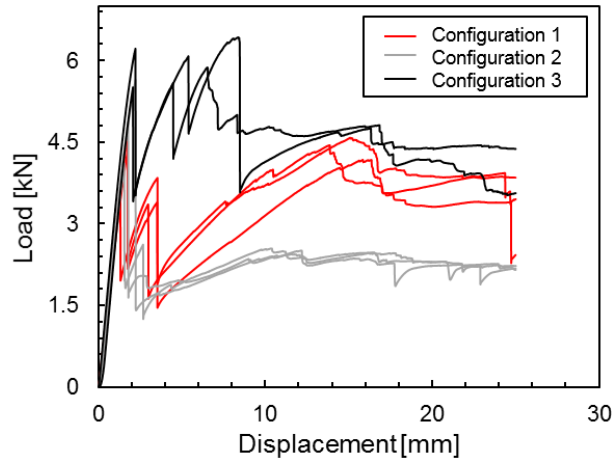
Figure 8. Comparison between the experimental load–displacement curves of ‘Configuration 1’, ‘Configuration 2′ and ‘Configuration 3′ .